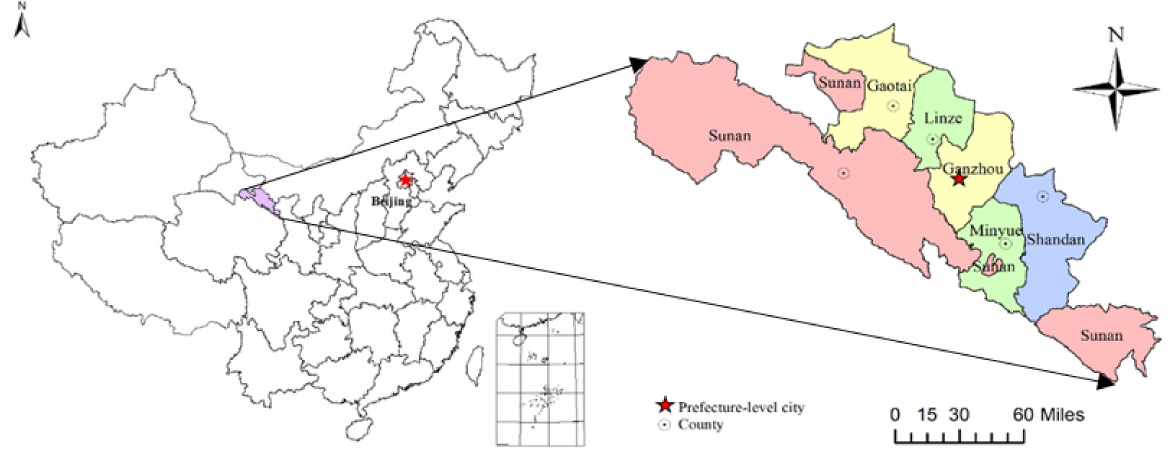
Figure 1. The administrative divisions of Zhangye city.